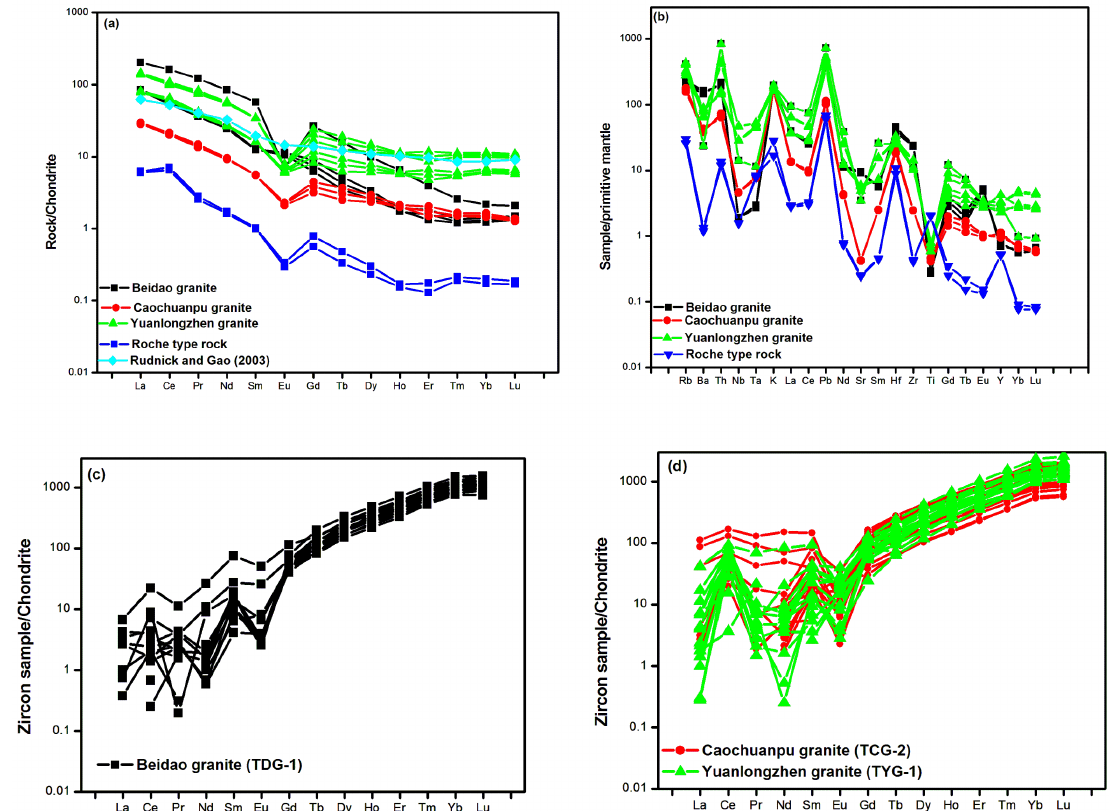
Figure 8. ( a ) Chondrite-normalized rare earth element (REE) diagram for the analyzed samples. ( b ) Primitive mantle-normalized diagram for the analyzed samples. Normalizing values for REE and trace elements are from [62]. ( c ) Chondrite-normalized REE patterns of the dated zircons from the Beidao granite. ( d ) Chondrite-normalized REE patterns of the dated zircons from the Caochuanpu and the Yuanlongzhen granites.